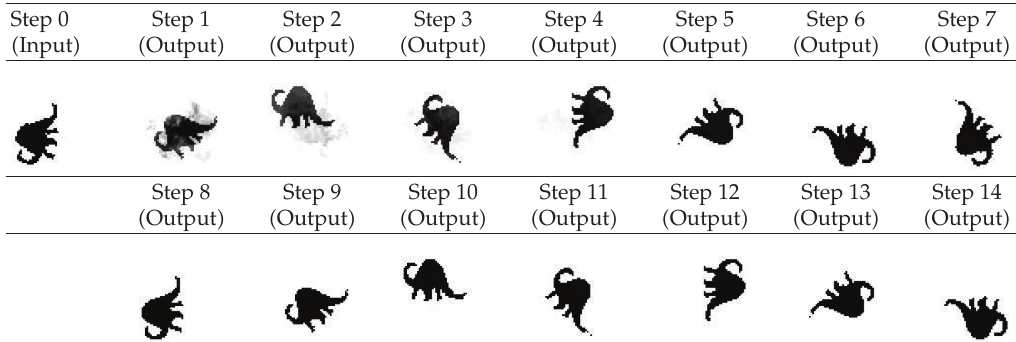
Table 10: Network recall using a di ff erent planar rotation: 275 ◦